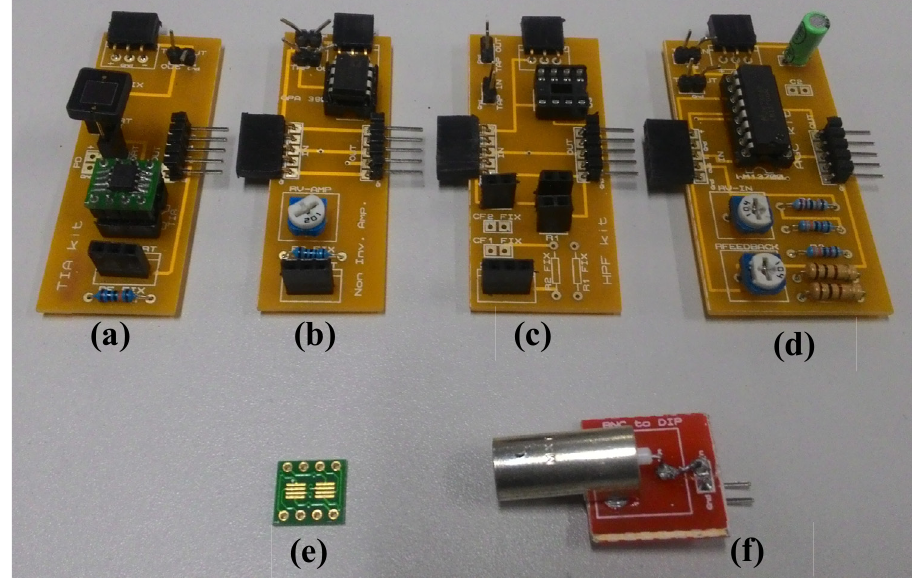
Fig. 11. The PCB design of proposed analog front-end receiver: (a) TIA kit with 23.30mm x 62.65mm; (b) non-inverting amplifier with 21.50mm x 62.65mm; (c) Sallen- key high pass filter as static interference noise filtering system with 26.75mm x 62.65mm; (d) AGC using LM13700 with 32.25mm x 62.65mm; (e) SOIC8 to DIP8 converter; (f) BNC female